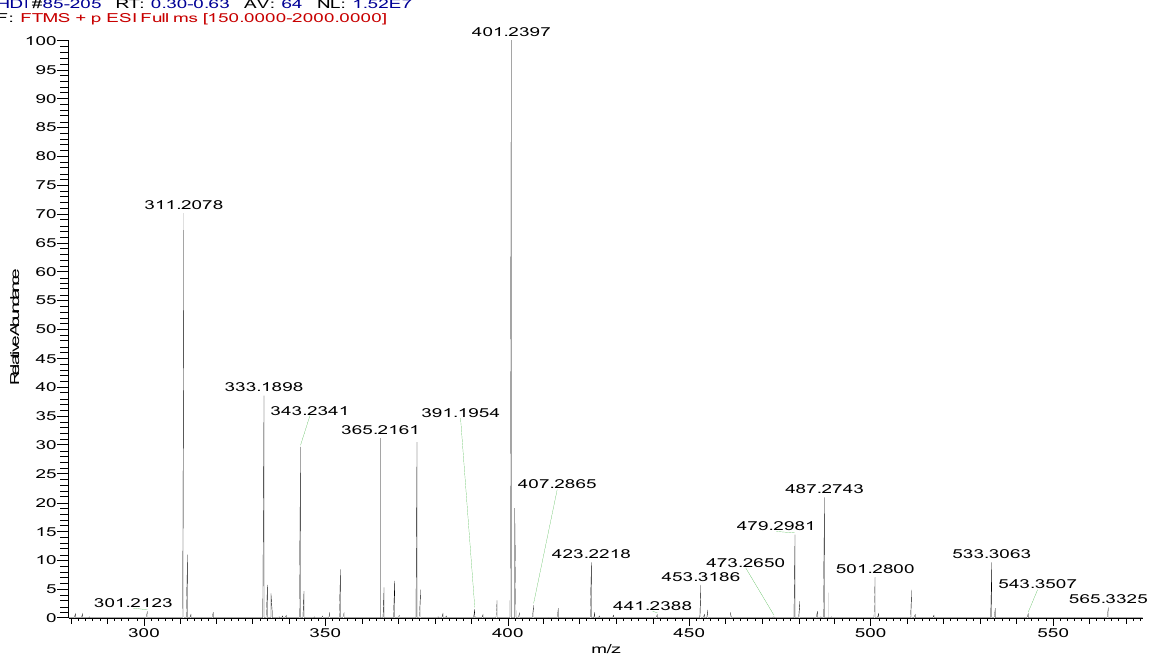
Figure 13. ESI mass spectrometry data for HDI.